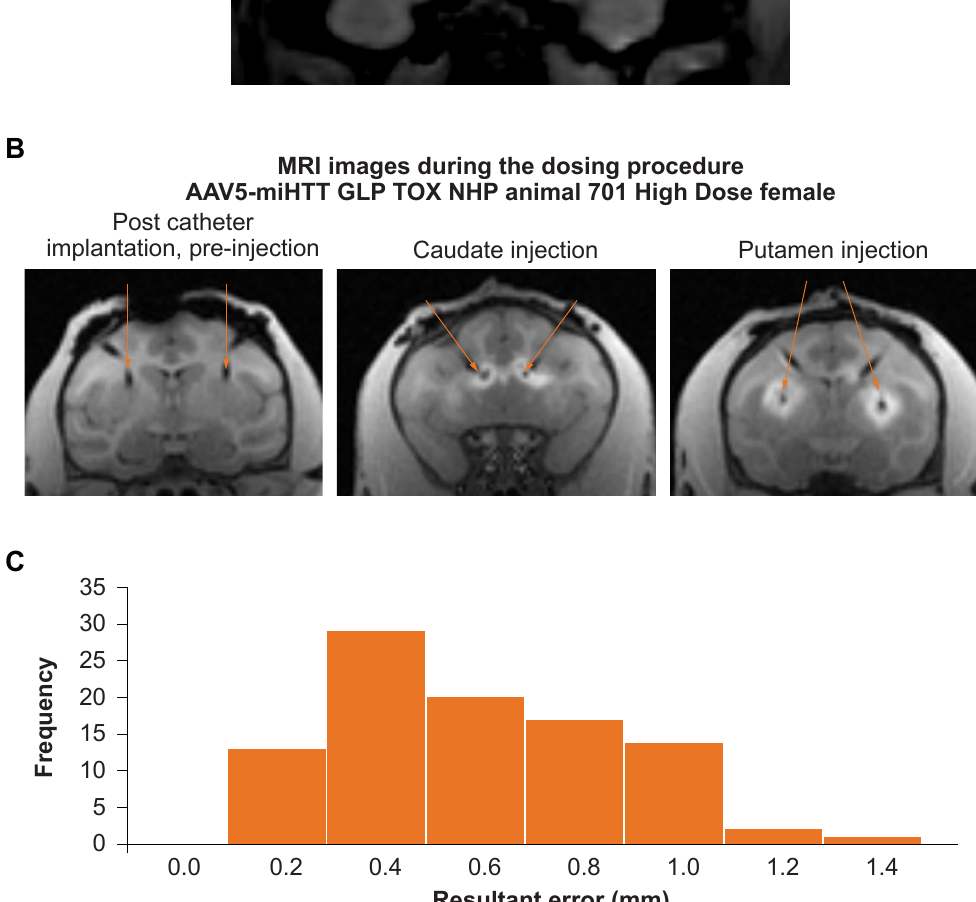
Figure 1. Successful MRI guided convection enhanced delivery of AAV5-miHTT to non-human primates (NHP). ( A ) The trajectory of the cannulas going into the target brain regions was planned based on individual animal MRI to calculate the exact coordinates of the trajectory. ( B ) Intra-operative MRI allowed close monitoring of the injections, with the left panel showing catheter placement before the injection (indicated by the orange arrows), and the middle and right panel showing the gadolinium signal of caudate nucleus and putamen being injected, respectively. ( C ) The error between the planned and actual injection location of all injections was measured based on the gadolinium signal. Nearly all (97%) injections were within 1 mm of the planned location within the target brain area, showing high accuracy. The graph shows how frequently (out of 96 in total) the resultant error of a certain distance was